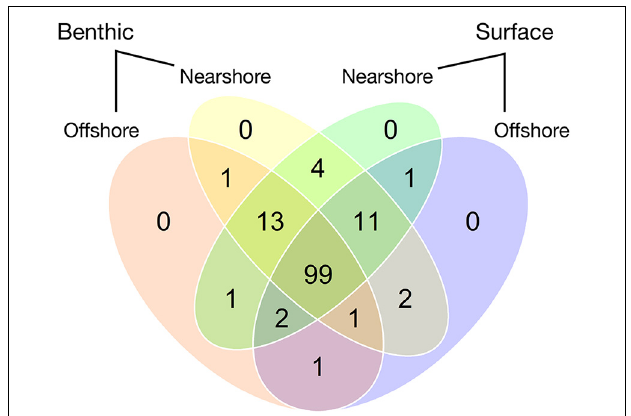
FIGURE 3 | Numbers of major taxa common to the four spatial compartments of eDNA sampling across six lakes. Major taxa are defined as the set of 136 identified plant and algal species (or, rarely, higher taxa) that were used for community analysis after the rarest taxa were excluded as described in Statistical Analyses, above.